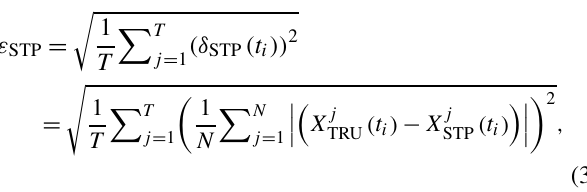
Figure 2. 15 April 2015 00:00 example of the developed methodol- ogy applied to the BoB HFR system. (a) The past 48h of the target field for the test period. (b) The analog having the lowest error. (c) The truth trajectories for the forecast period. (d) The STP trajecto- ries. The initial positions of the particle trajectories are indicated by the blue dots, and the red dots indicate the position after 48h.